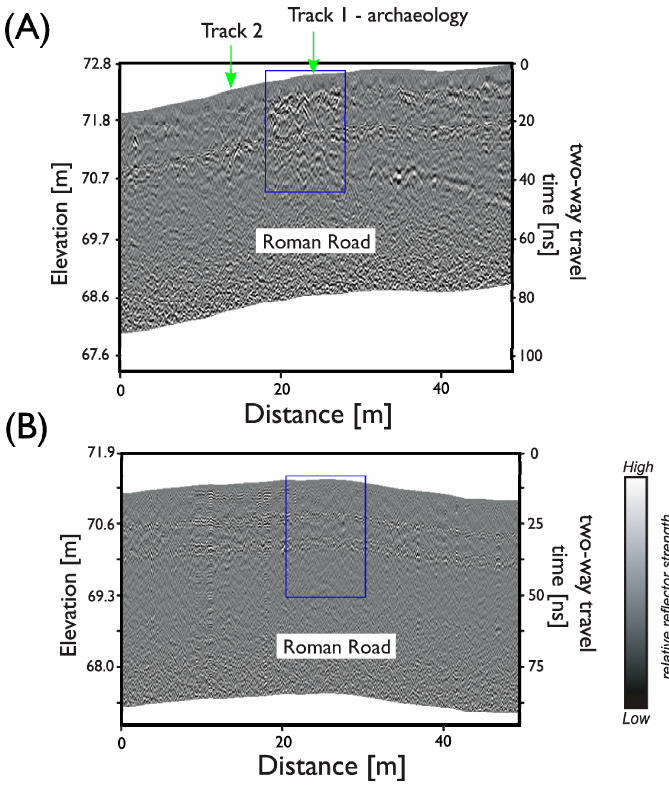
Figure 6. GPR profiles over ( A ) the well-preserved section of Roman road (shown by a blue box) to the west of Queen Anne’s Avenue and ( B ) in the former arable field to the east. The location of the two equine locomotion analysis test tracks is also shown by the green arrows in ( A ) where the depth from the ground surface to the anomaly due to the Roman road is approximately 0.25 m.